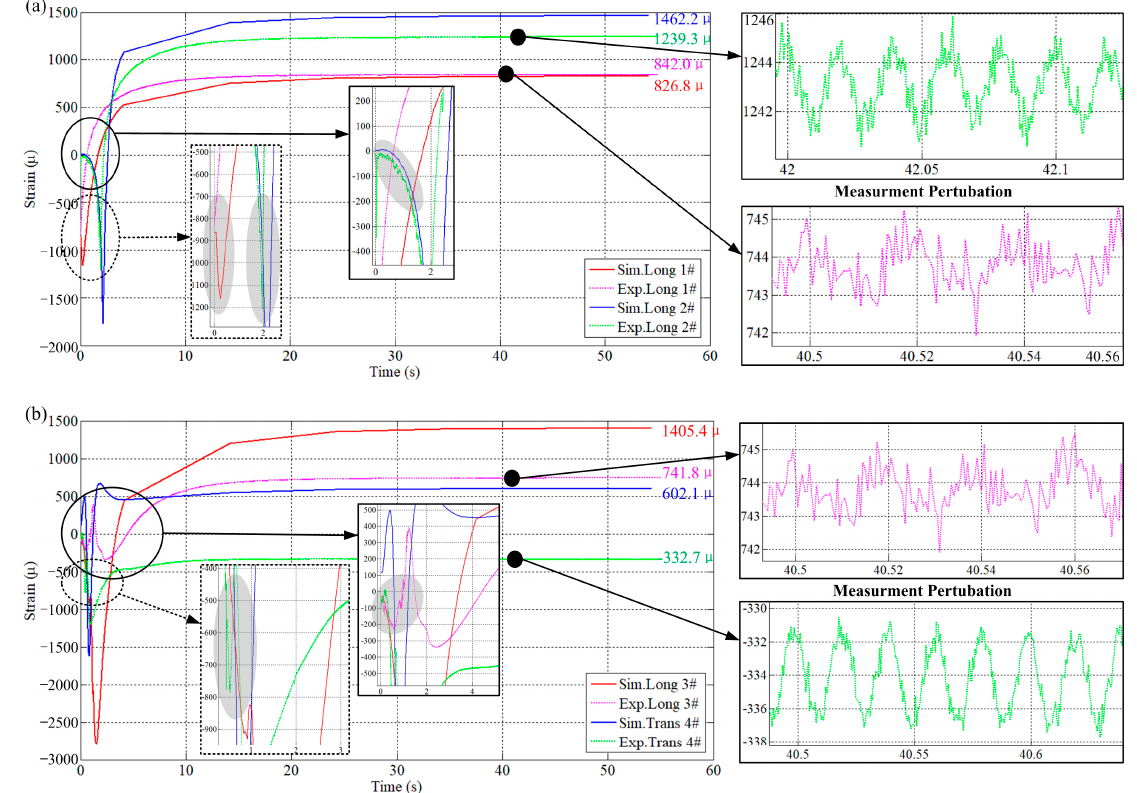
Figure 8. Transient strain of experiment and simulation results: ( a ) 1# and 2#, ( b ) 3# and